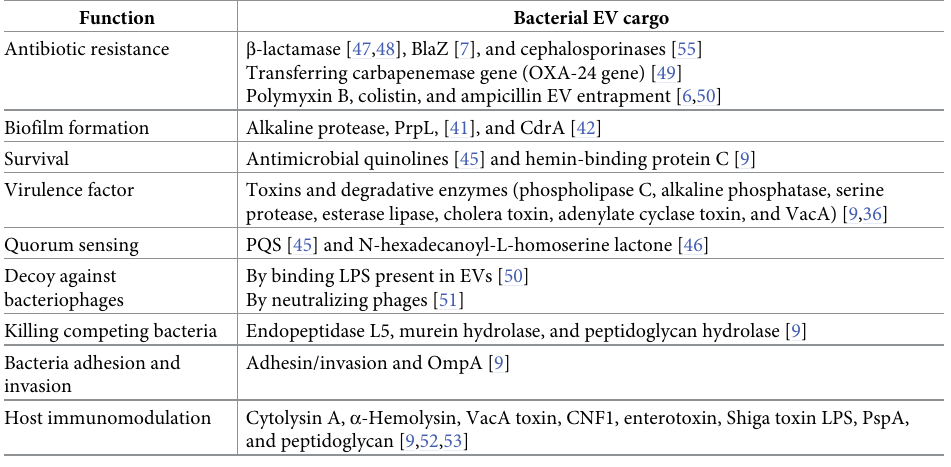
Table 1. Bacterial EV cargo components and their